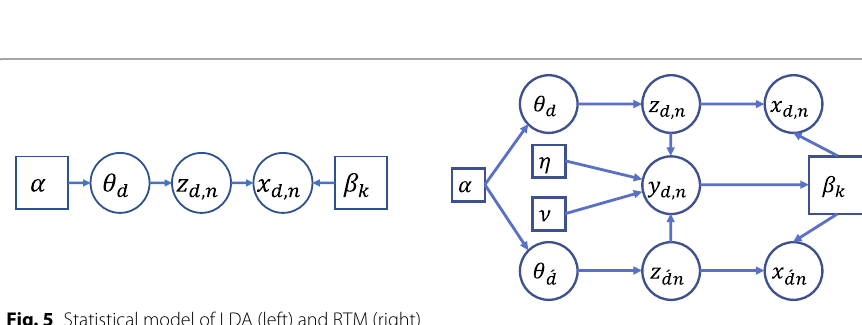
Fig. 5 Statistical model of LDA (left) and RTM